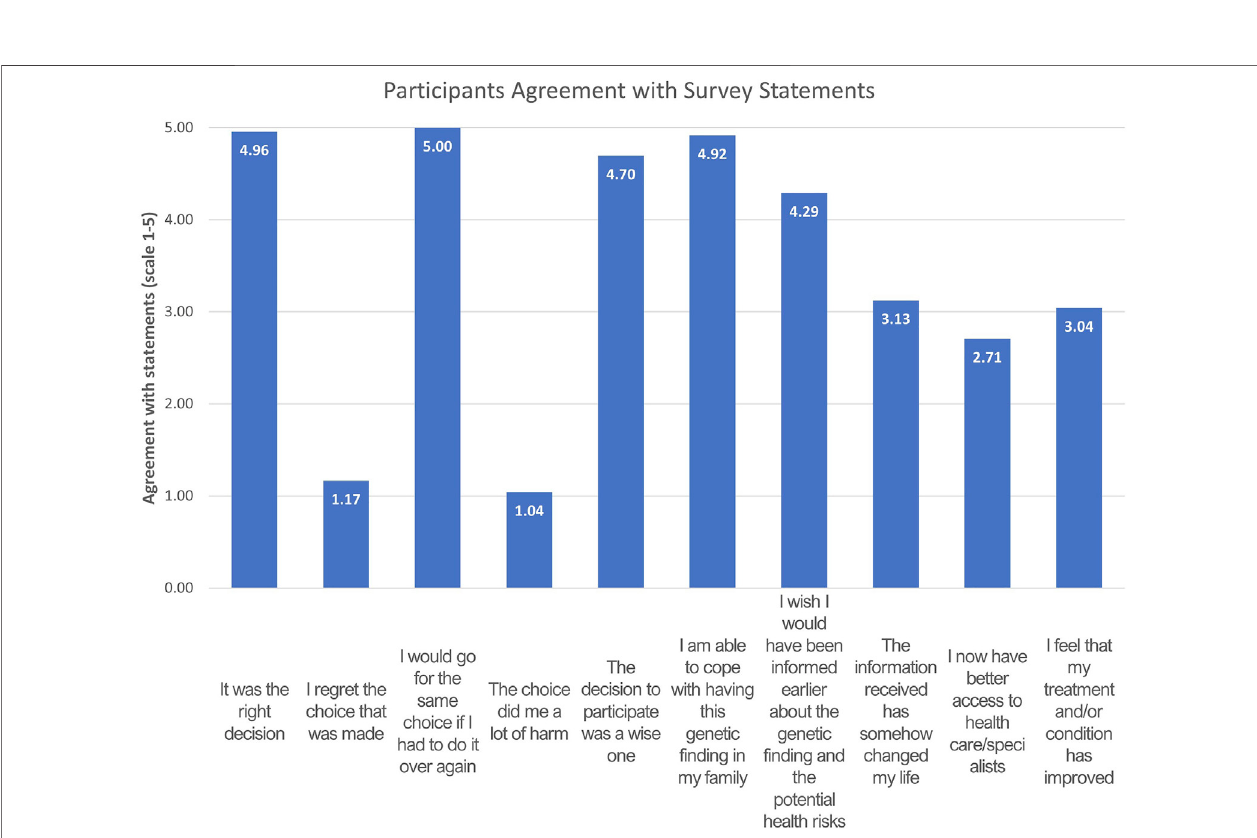
FIGURE 3 | Mean values for answers given to the fi rst portion of the RbG feedback survey where the participants were asked to rate their agreement with the following statements ( n = 24). The answers were converted to numeric values according to the scale: “ agree ” -5, “ slightly agree ” -4, “ unsure ” -3, “ slightly disagree ” -2. “ disagree ” -1. Mean values above three signify agreement with the speci fi c